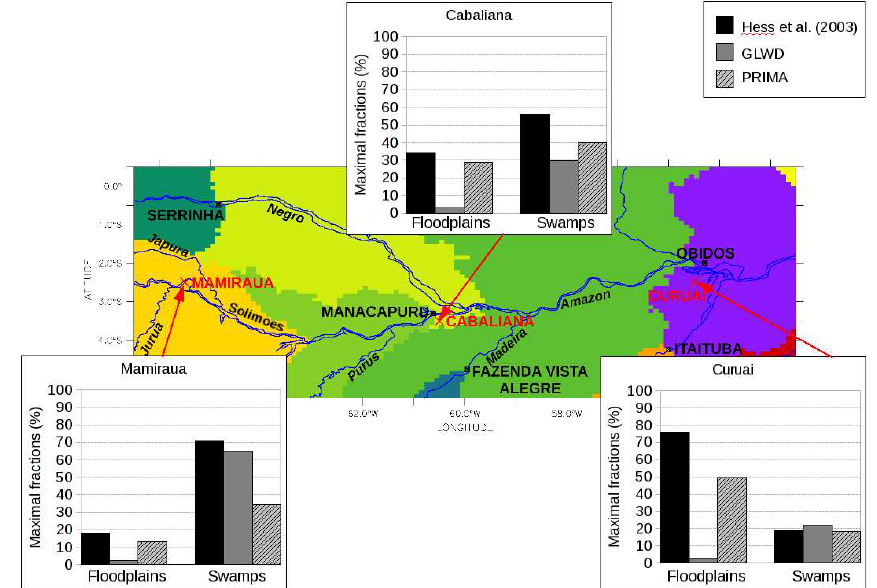
Fig. 6. Comparison of MFF and MFS to Hess et al. (2003)’s observations in different parts of the main stem: Mamiraua near Tef´e, Cabaliana near Manacapuru and Curuai near ´Obidos. Floodplains from Hess et al. (2003) are considered as the sum of “Non vegetated-flooded” and “Non woody-flooded” classes. Swamps are considered as the equivalent of “Woody-flooded” class. Color is used to distinguish the different sub-basins.